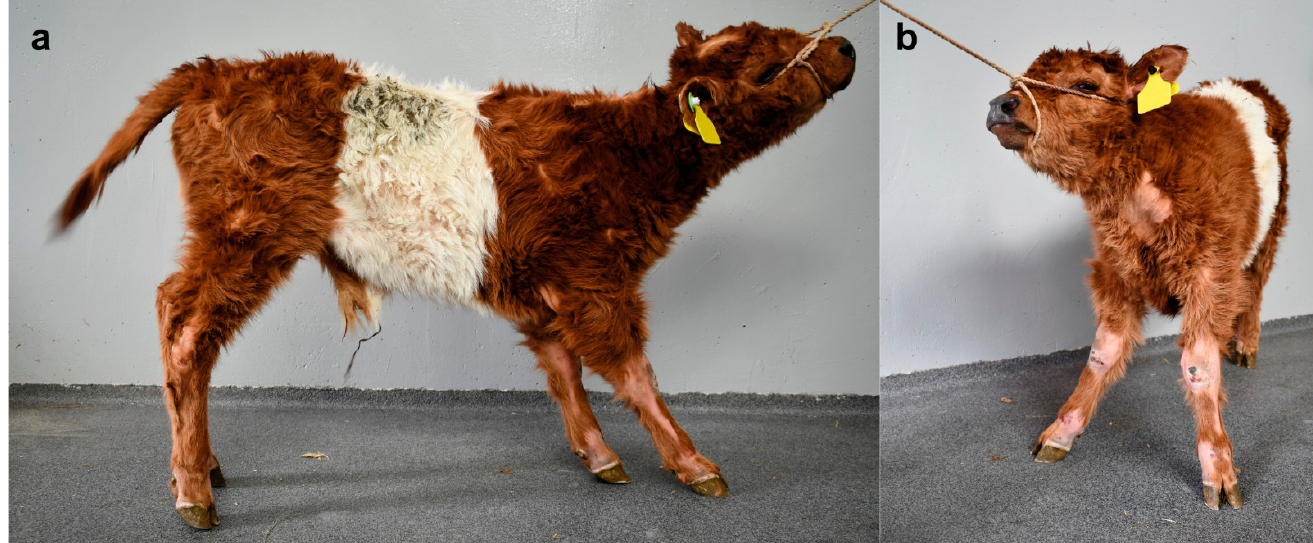
Figure 1. Congenital hypotrichosis in a Swiss Belted Galloway cattle. ( a ) Note the multiple areas of alopecia on the limbs and the dorsal part of the head. ( b ) Note the large alopecic lesions located on the neck and the dorsal aspect of the fetlock and carpal joints. Note also the excoriations on the dorsal aspect of the fetlock and carpal joints.